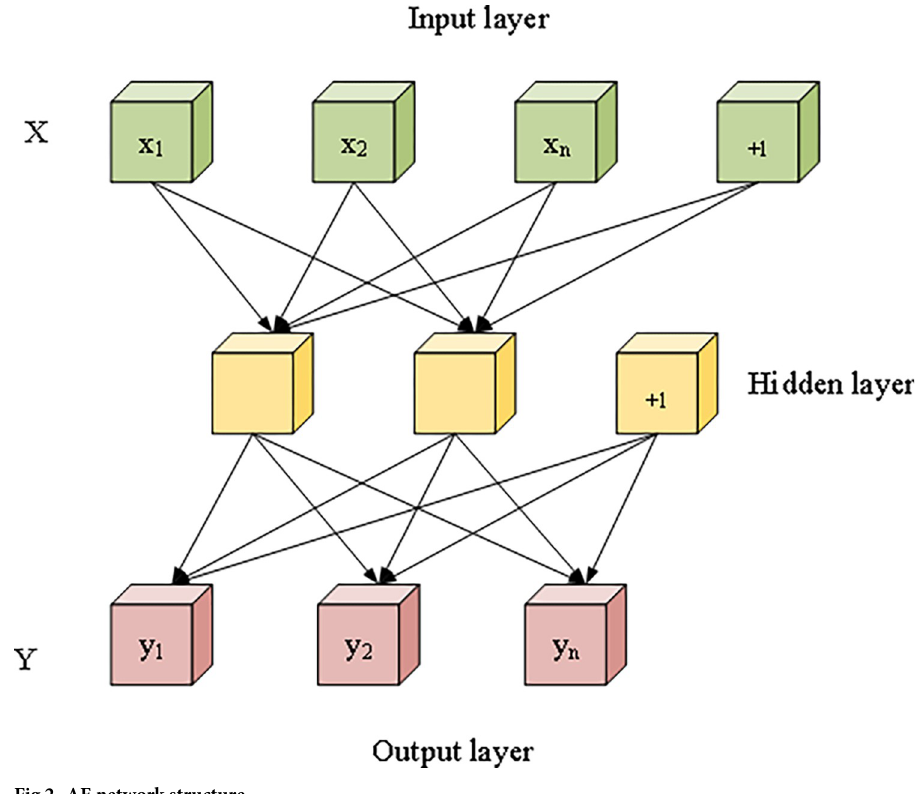
Fig 2. AE network